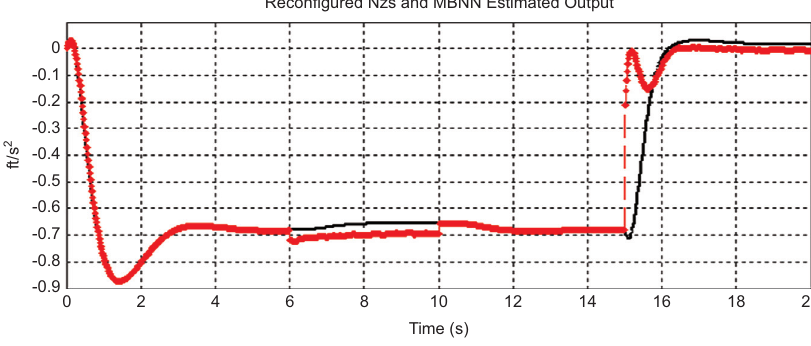
Figure 14. SFDA for Intermittent Stuck Sensor Fault; Nz Switching Back as Fault is Cleared at 10